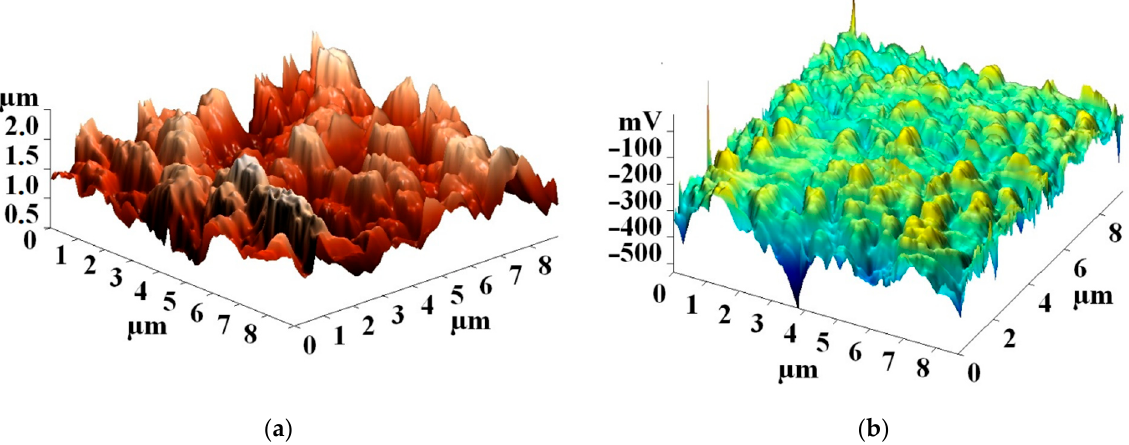
Figure 5. Topology ( a ) and distribution of the surface potential ( b ) of the aligned multi-walled CNTs combined into bun- dles.